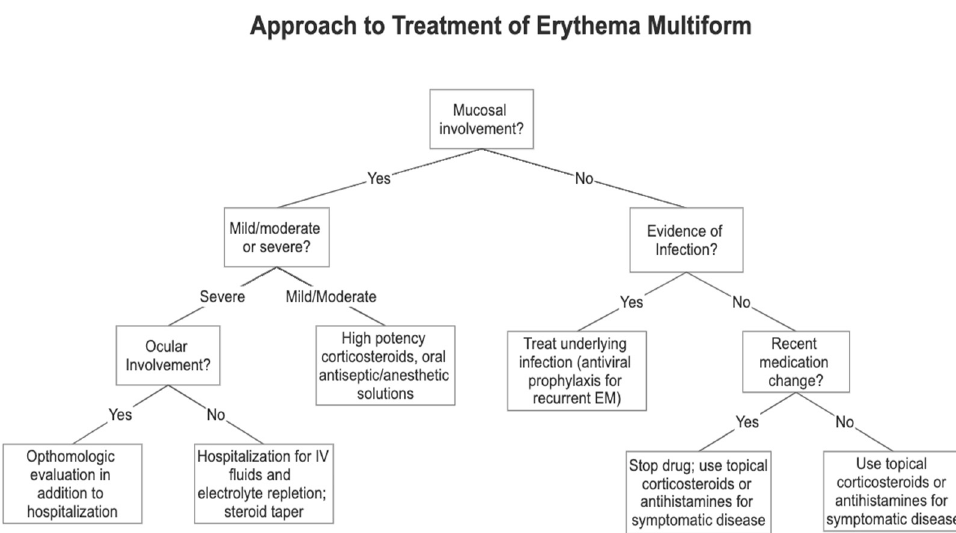
Figure 1. This flowchart details the clinical approach to treating each type of EM based on the clinical features of mucosal involvement, severity of disease, and infection or drug association. Adapted from “Erythema Multiforme: Recognition and Management” by Trayes et al. [2] with permission from the American Academy of Family Physicians, © 2021.